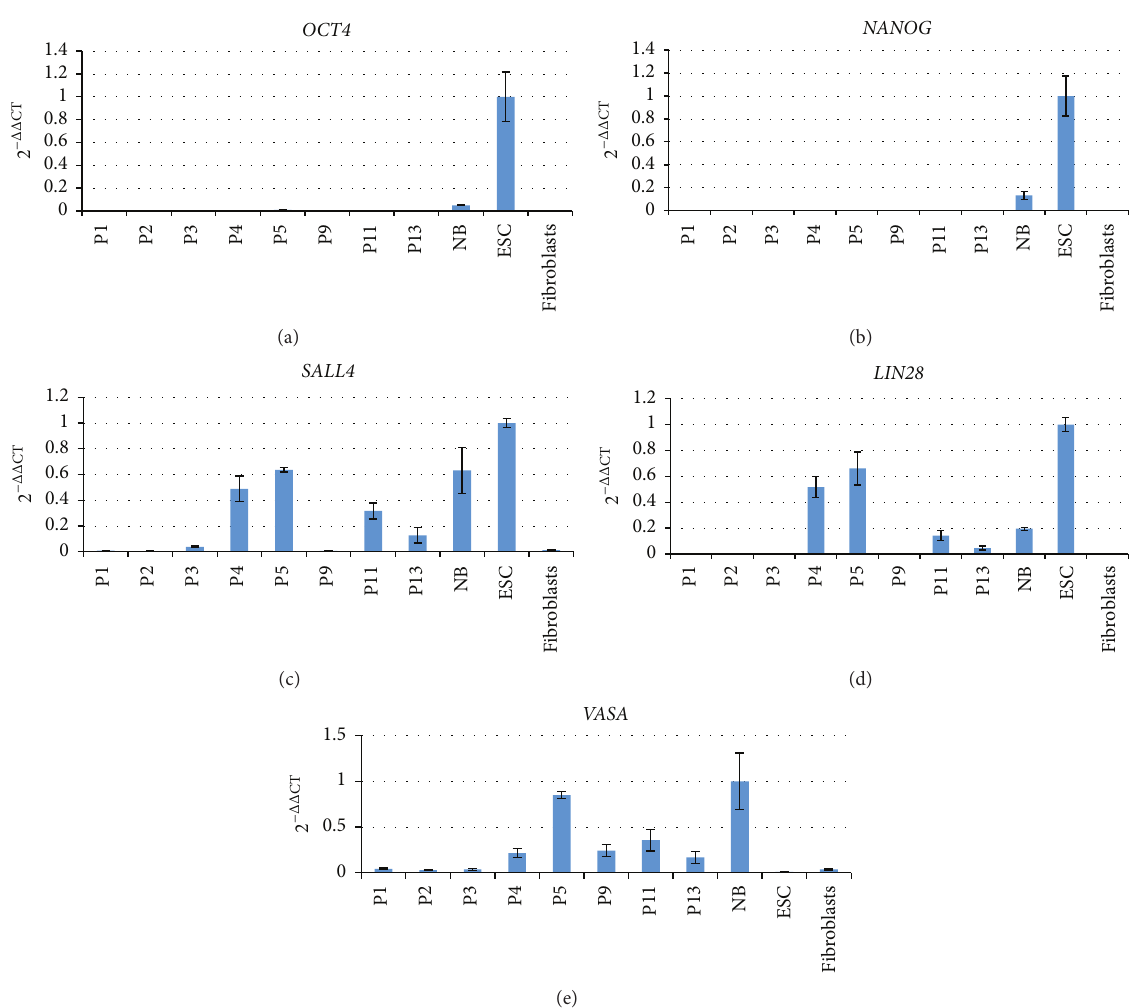
Figure 3: RT-qPCR analysis of OCCs in different passages. Real-time quantitative RT-PCR analysis of selected key pluripotency and germ cell markers in OCCs. OCT4, NANOG, SALL4 , and LIN28 are all robustly expressed in pluripotent stem cells as well as in primitive germ cells. In contrast OCT4 and NANOG are absent from OCCs. SALL4 and LIN28 were absent or very low at low passages and increased in expression at higher passages. VASA is a general germ cell marker and was detected in later OCC passages and in the neonatal